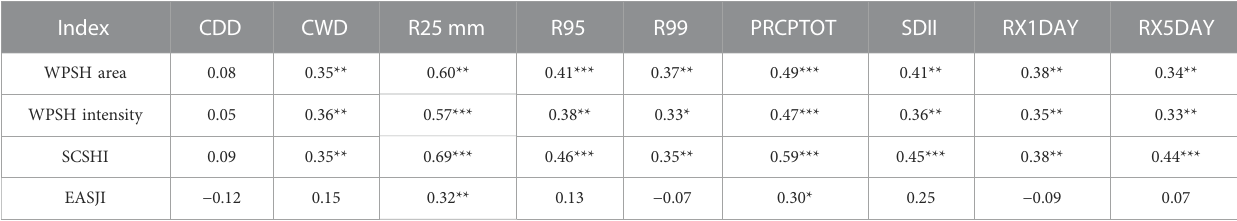
TABLE 2 The correlation coef fi cient of atmospheric circulation indices with annual mean precipitation indices in the MLYR from 1979 to 2015.